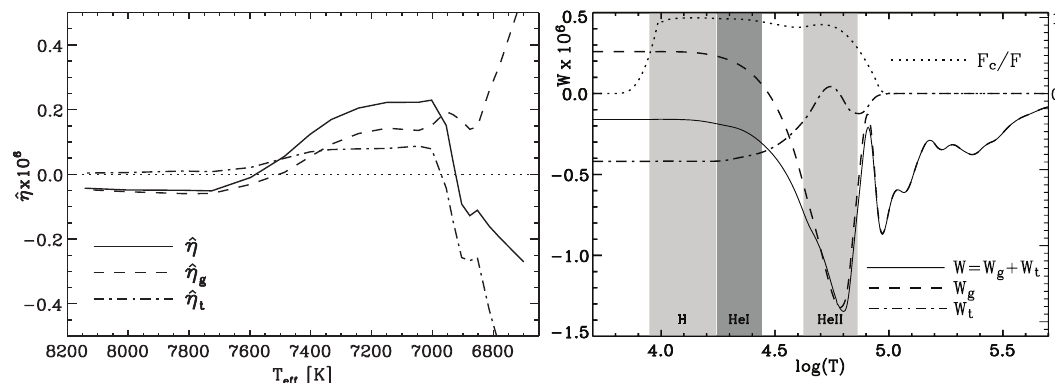
Figure 5: Mode stability of an 1 . 7 𝑀 ⊙ Delta Scuti star computed with Gough’s (1977a,b) convection model. Left: Stability coefficient ^ 𝜂 = 𝜔 i /𝜔 r as a function of surface temperature 𝑇 eff across the instability strip. Results are shown for the fundamental radial mode ( 𝑛 = 1). Positive ^ 𝜂 values indicate mode instability. The separate contributions to ^ 𝜂 arising from the gas pressure perturbations, 𝜂 g , and from the perturbation of the momentum flux, 𝜂 t , with 𝜂 = 𝜂 g + 𝜂 t , are obtained from the evaluation of the work integral (132). Right: Integrated work integral 𝑊 as a function of the depth co-ordinate log( 𝑇 ) for a model lying just outside the cool edge of the instability strip (surface temperature 𝑇 eff = 6813 K). Results are plotted in units of ^ 𝜂 . Contributions to 𝑊 (solid curve) arising from the gas pressure perturbation, 𝑊 g (dashed curve), and the turbulent pressure perturbations, 𝑊 t (dot-dashed curve), are illustrated ( 𝑊 = 𝑊 g + 𝑊 t ). The dotted curve is the ratio of the convective to the total heat flux 𝐹 c /𝐹 . Ionization zones of H and He (5% to 95% ionization) are indicated (from Houdek,